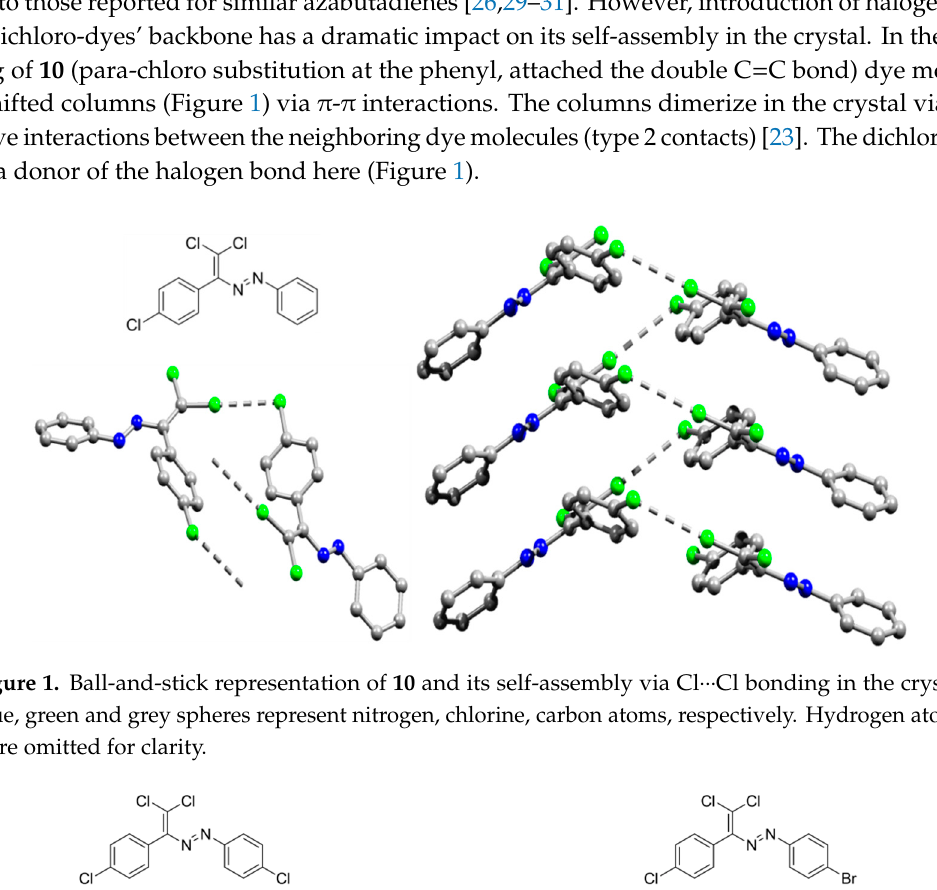
Figure 2. Ball-and-stick representations of 14 and 15 and their self-assembly via Cl···Hal bonding in the crystal. Olive-green, blue, green, and grey spheres represent bromine, nitrogen, chlorine, and carbon atoms, respectively. Hydrogen atoms were omitted for clarity.